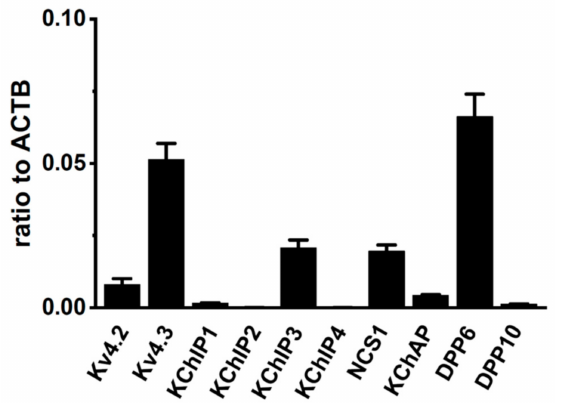
Figure 2. Molecular identification of A-type K + channel α and β subunits (Kv4 α and Kv4 β ) in vas deferens smooth muscles (VDSMs). Quantitative real-time PCR for Kv4 α (Kv4.2, Kv4.3) and Kv4 β (KChIP1-3, KChAP, DPP6, and DPP10) expression in the vas deferens of 7 week-old male rats ( n = 6). Values are shown for steady-state transcripts relative to β -actin (ACTB) in the same